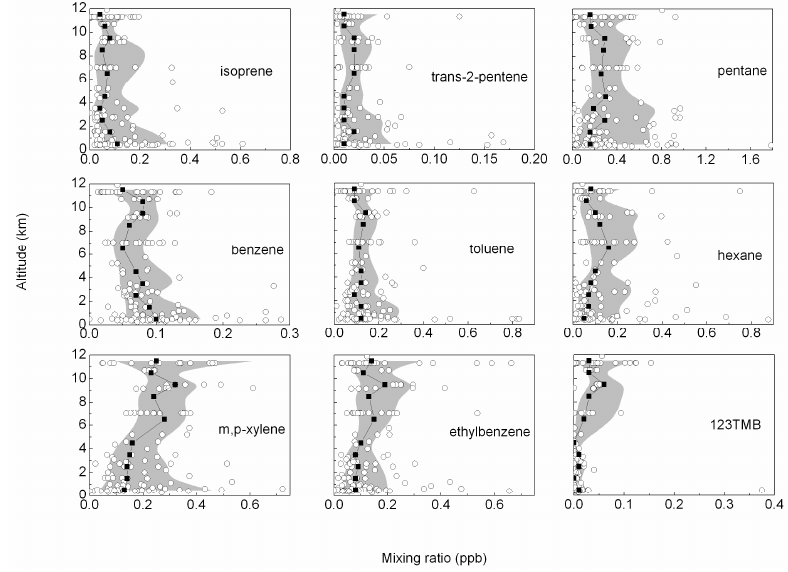
Fig. 3: Vertical profiles of a selection of NMHC collected on both aircrafts during SOP 2a2. Open markers are all observations. Black markers are average values in altitude bins of 1 km. Grey area represents standard deviations for all observations.